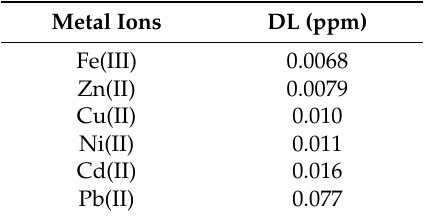
Table 3. Detection limit (DL) of the MMCS6CS system.